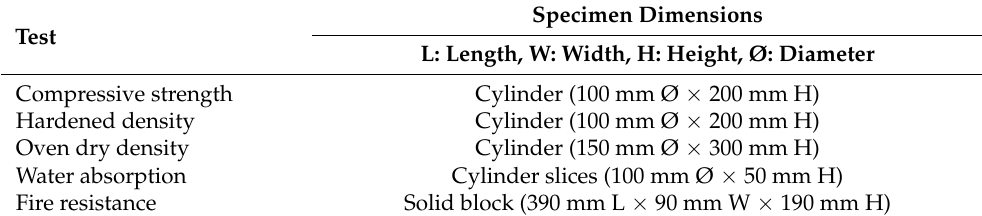
Table 3. Details of test specimens.